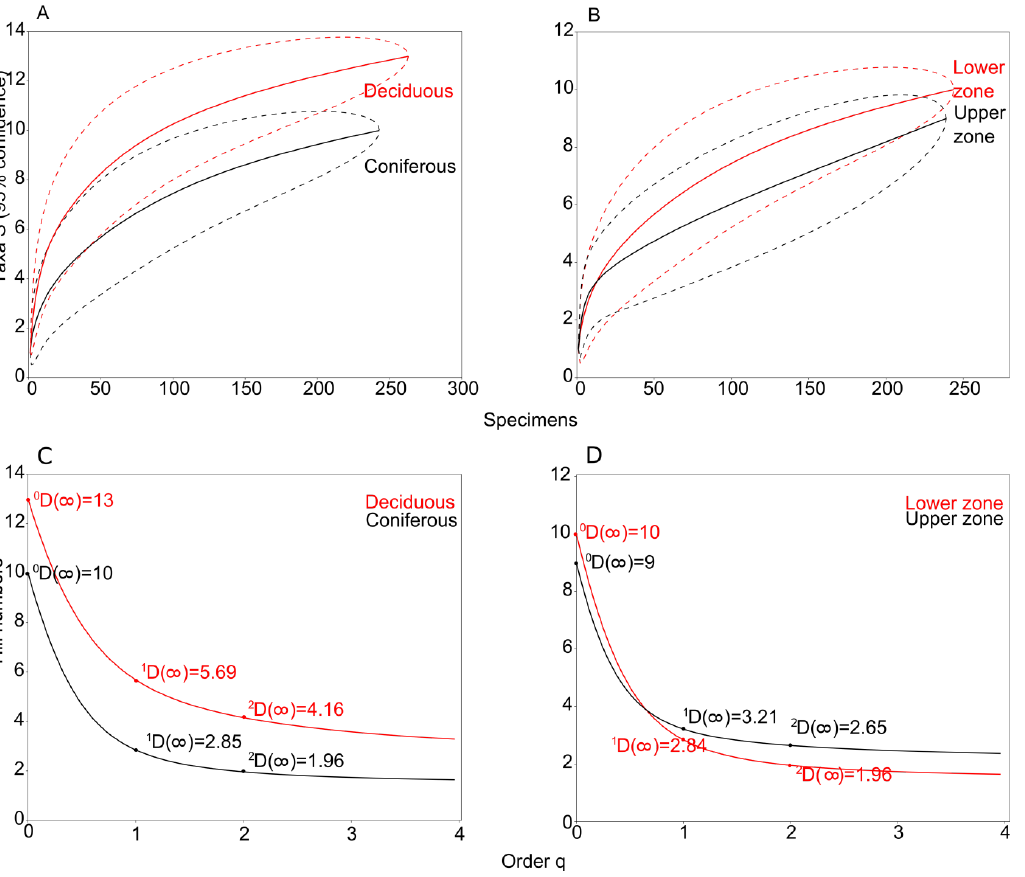
Figure 8. Rarefaction curves with 95% confidence intervals for species richness of bats ( A, B ) and diversity profile curve plotting Hill numbers ( C, D ) for the deciduous and coniferous forests of lower forest zone (data from upper forest zone were excluded from analysis due to lack of deciduous forest in this belt) and undisturbed coniferous forests of lower and upper forest zone in the Polish Tatra Mountains, 2016 – 2020.